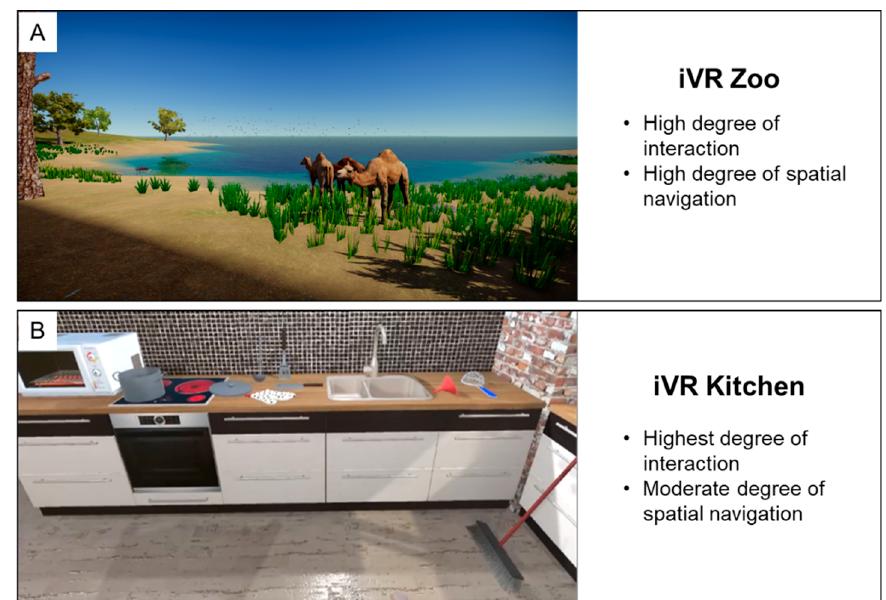
Figure 5. Overview of iVR Kitchen and Zoo differences. ( A ) The iVR Zoo provided a high degree of interaction via clicks on animals to hear their Chinese words and a high degree of spatial navigation through the ability to both walk in real space and use the teleport function. ( B ) The iVR Kitchen provided the highest degree of interaction via clicks on items to hear their Chinese words as well as the ability to move objects, while offering a moderate degree of spatial navigation via the ability to walk in a real space.